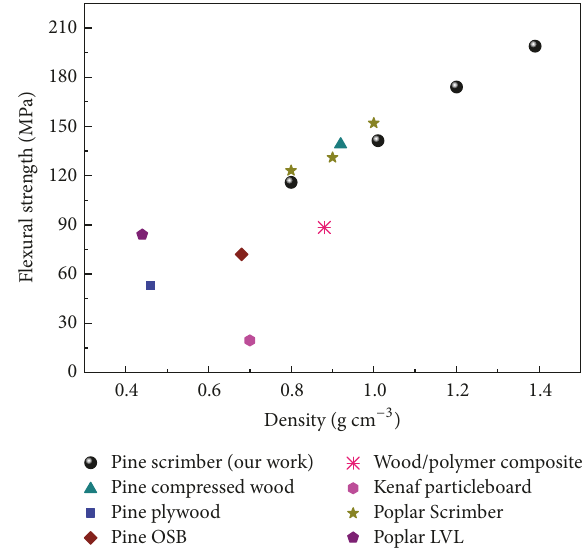
Figure 6: Comparison of flexural strength between the scrimbers and selected wood-based panels.